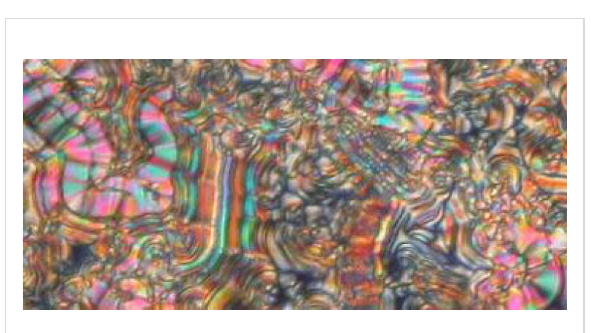
Figure 5: Compound OH 2a : Texture of the SmCP phase at 126 °C.